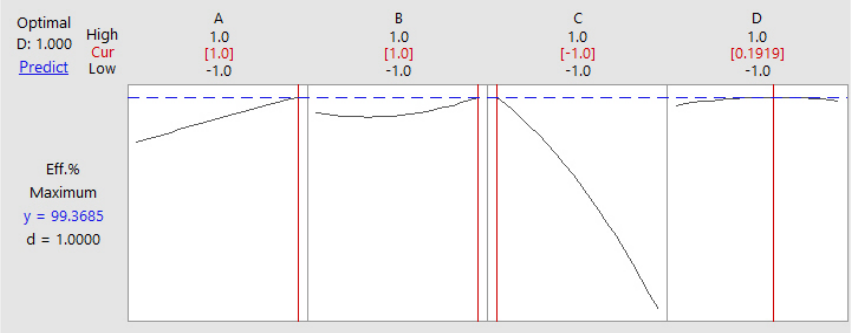
Figure 6. Prediction of the optimum efficiency (dotted blue line) of inhibitor O to protect steel CR4 against corrosion in salt water (course of the black line, best level indicated in red). Optimization and prediction were performed by RSM with support from Minitab17.